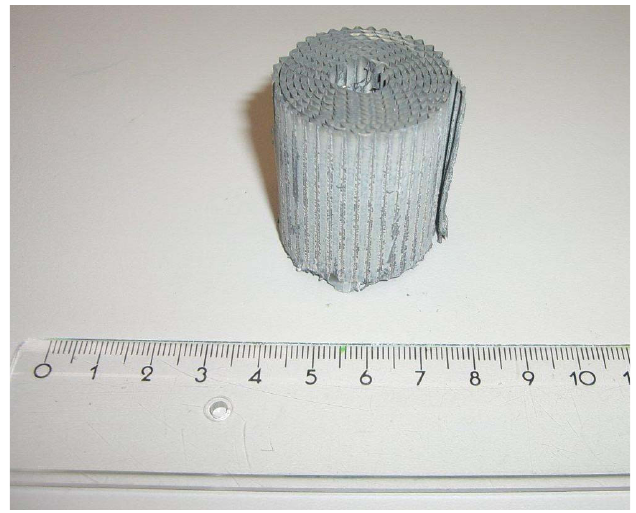
Figure 11. Photograph of the universal metal